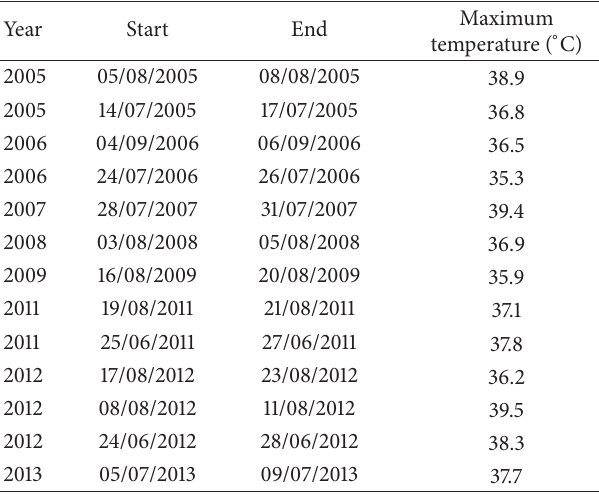
Table 1: Year, starting and ending date, and maximum temperature for each heat-wave event identified in the Iberian Peninsula from 2005 to 2014 (source: State Meteorology Agency (AEMET),